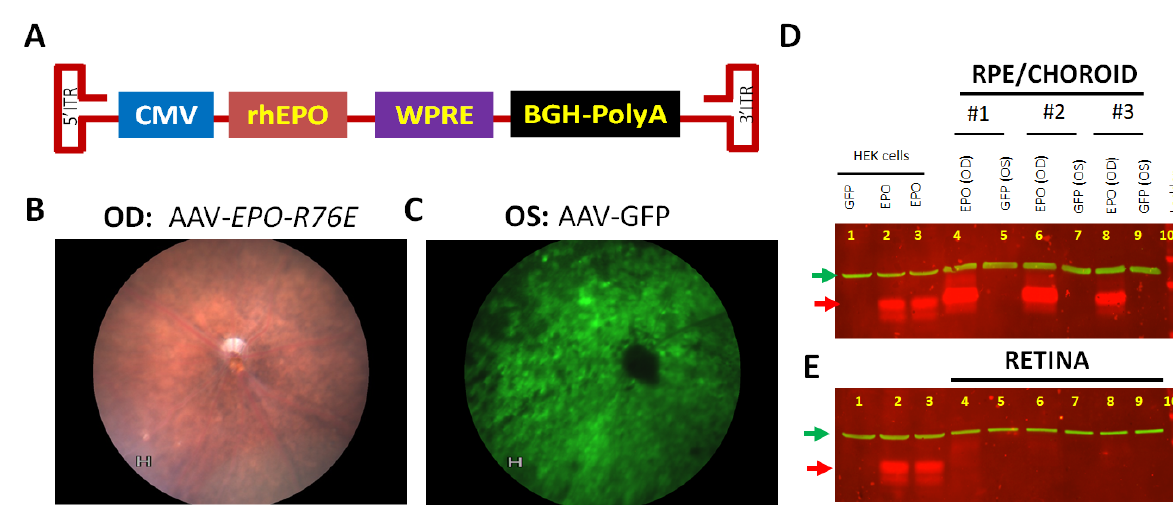
Figure 2. AAV-mediated protein expression in the retina. ( A ) The AAV plasmid contains rhesus EPO-R76E (rhEPO) cDNA driven by cytomegalovirus immediate early (CMV) promoter [24] and contains the Woodchuck Hepaititis Postransciptional Regulatory Element (WPRE). The vector was packaged as serotype 1 (AAV1) to promote RPE-specific transduction. The AAV-EPO-R76E experimental vector was injected in one eye of 2–3-month-old mice ( B ), and the contralateral eye was injected with control vector, AAV-GFP. One month following subretinal gene delivery GFP fluorescence ( C ) was noticed around the optic nerve by fundus imaging. Exogenous EPO-R76E was significantly increased ( D ) in the RPE/choroid of Sod2 flox/flox /VMD2-cre mice (red arrow) injected with the AAV-EPO-R76E vector (lanes 4, 6 and 8) compared to eyes injected with the control AAV-GFP vector (lanes 5, 7, and 9), using an EPO specific antibody and β -actin used as a loading control (green arrow). ( E ) EPO levels were minimal (Lane 4, 6, 8) in the retinas of the same eyes. Proteins from GFP transfected HEK cells (lane 1) and EPO plasmid transfected HEK cells (Lane 2 and 3) were used in both the gels to have negative and positive control for retinal